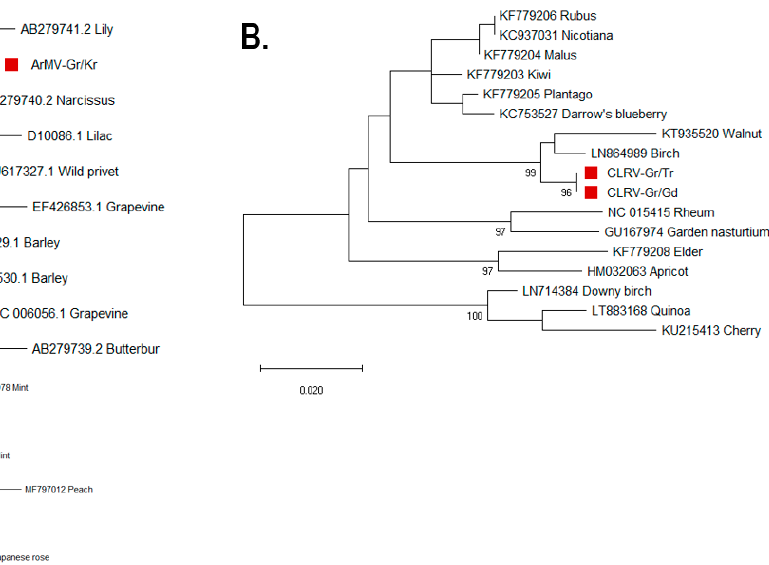
Figure 1. Phylogenetic trees conducted in MEGA X software, using nucleotide alignments of the partial CP gene of ArMV (A), and the 3΄UTR of CLRV (B) and SLRSV (C). This analysis involved: ten nucleotide sequences with a total of 262 positions in the final dataset for ArMV (A); 17 nucleotide sequences with a total of 338 positions in the final dataset for CLRV (B); and 14 nucleotide sequences with a total of 246 positions in the final dataset for SLRSV (C). The avail- able virus sequences are reported with their accession numbers and the origin host, whereas the Greek isolates originating from olive and determined in this study are indicated by red squares and their designated isolate name. Branches with <85% bootstrap support were collapsed. The scale bar represents a genetic distance of